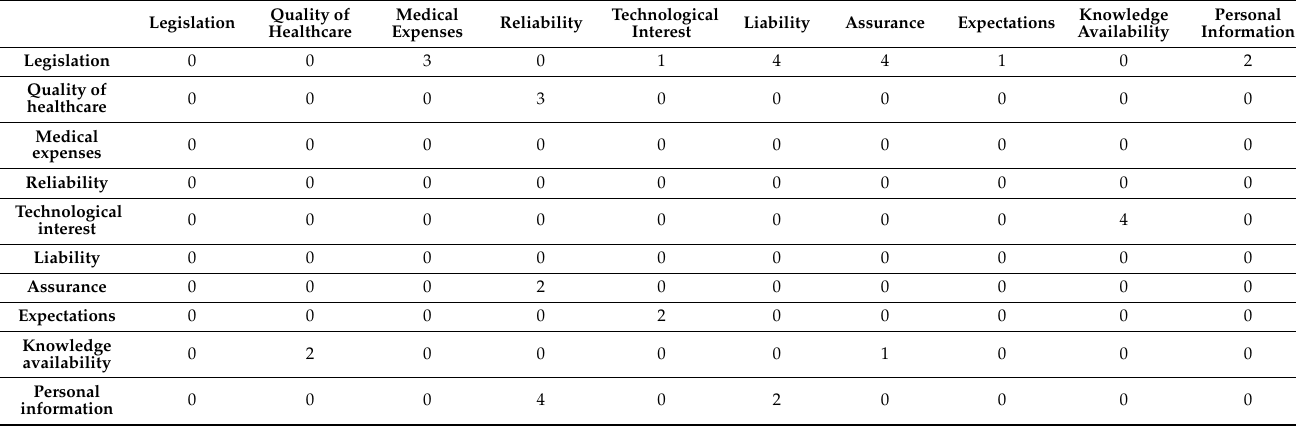
Table 3. Interpretive structural modeling relational